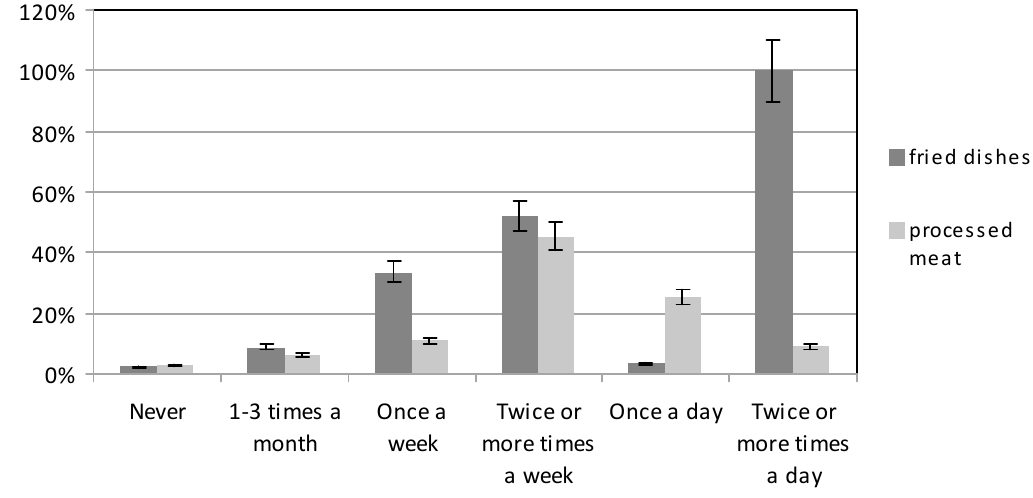
Figure 7. The consumption of fried dishes and processed meat products by participants.